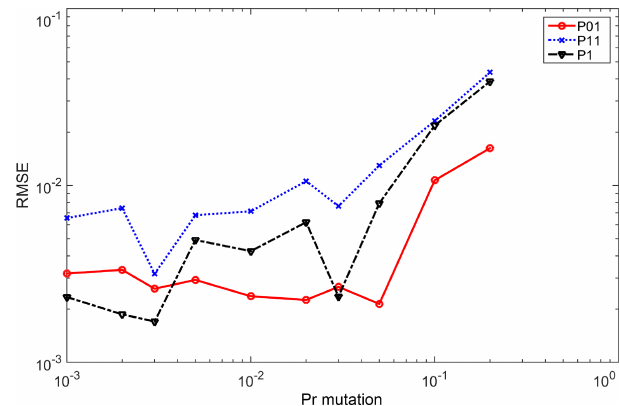
Figure 2. Testing for different probabilities of crossover P cr . RMSE is estimated for all the tested 12 stations for each transition and limiting probability of the simulated data with the record length of 100000.